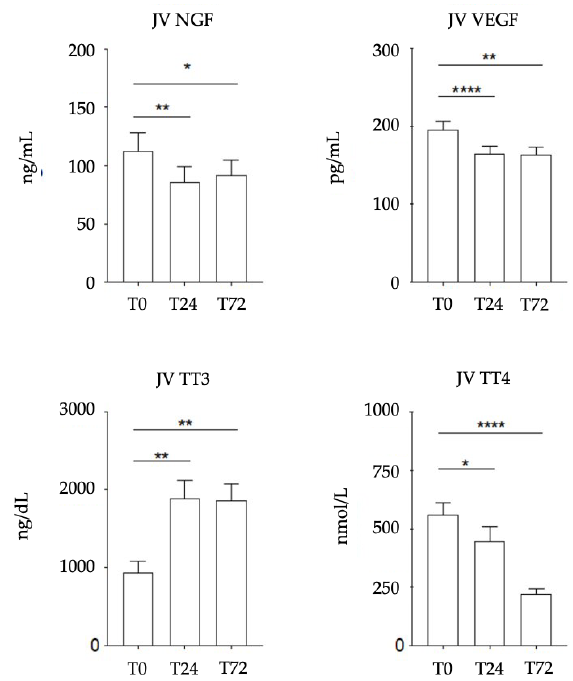
Figure 1. Time-dependent changes in plasma NGF – VEGF levels and serum TT3 – TT4 levels in jugular vein (JV) of healthy foals. T0: birth; T24: 24 hours from birth; T72: 72 hours from birth. NGF, VEGF and TT4 levels decrease significantly from T0 to T24 and from T0 to T72, whereas TT3 levels increase significantly from T0 to T24 and from T0 to T72. Statistical analysis: one-way ANOVA, with the Geisser – Greenhouse correction. Adjusted p values JV NGF: * = 0.0179; ** = 0.0066; adjusted p values JV VEGF: ** = 0.0016; **** < 0.0001; adjusted p values JV TT3: ** = 0.0058; ** = 0.0013; adjusted p values JV TT4: * = 0.0201; **** < 0.0001.